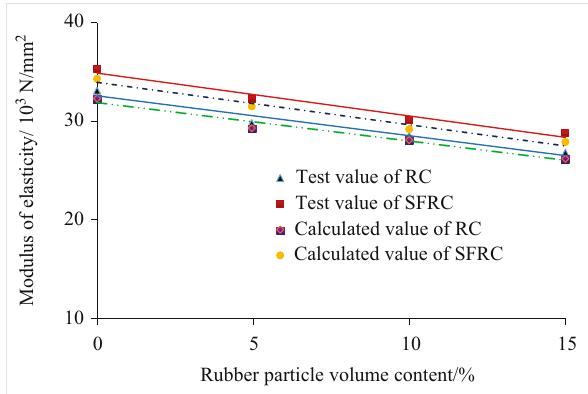
Figure 9: Elastic modulus of concrete with di ff erent mix